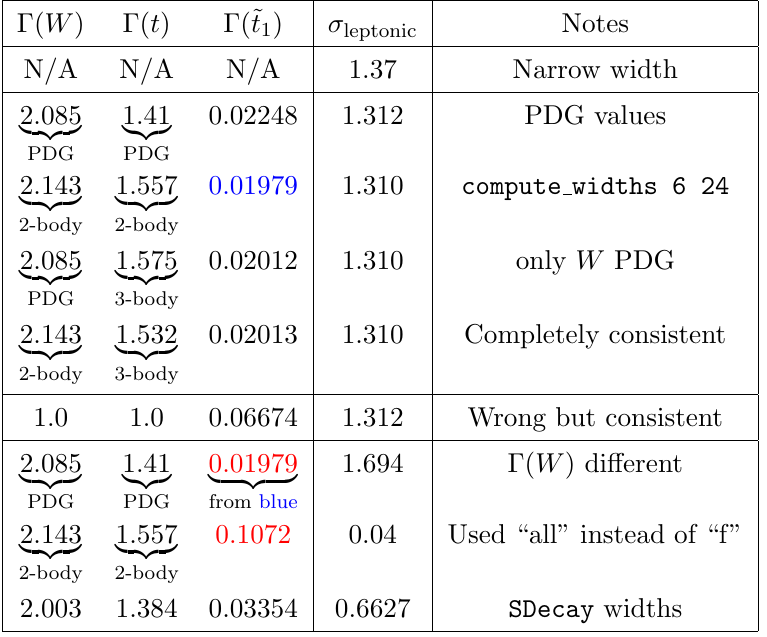
1 . We set m t = 173 : 1